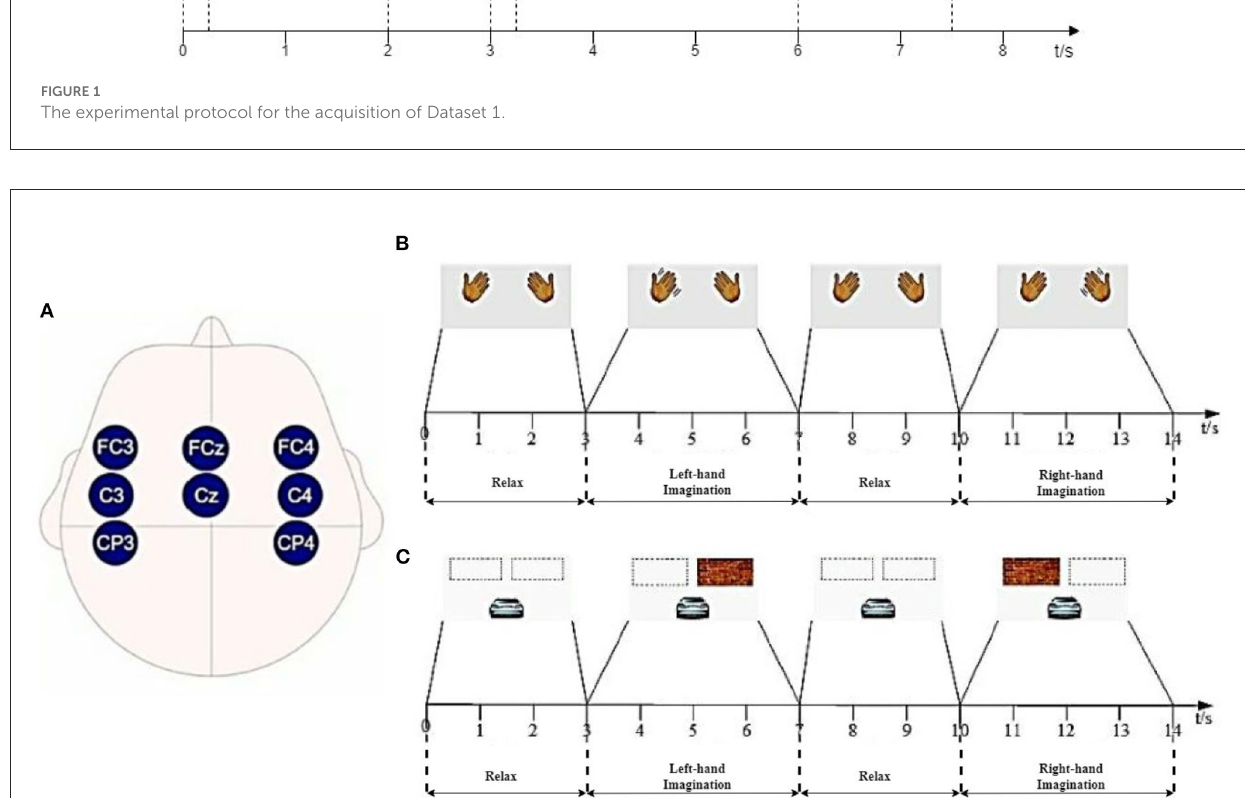
FIGURE2 Lead channel distribution and experimental paradigm of Dataset 1: (A) Lead distribution; (B) Offline experiments; (C) Online